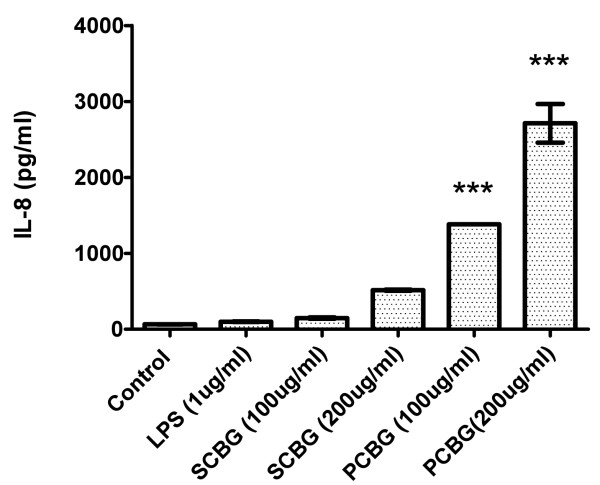
PCBG induces IL-8 release from 1HAEo- human airway epithelial cells. Cells were incubated with LPS, Saccharomyces cerevisiae β-glucan and Pneumocystis β-glucan at the indicated doses for a period of 14 hours. Release of IL-8 was measured by ELISA in the media supernatant of the cells. Data were analyzed with one-way ANOVA and posttest Dunnett's comparison test (*** denotes p < 0.001). The experiment shown is representative of three independent experiments.